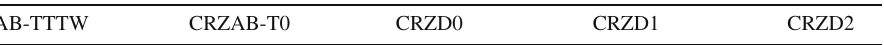
differ are highlighted by a thick border around the cell that contains the requirement. Requirements are made on the following variables in the signal regions but have no equivalent requirement in the control regions: τ -veto, m R = 0 . 8